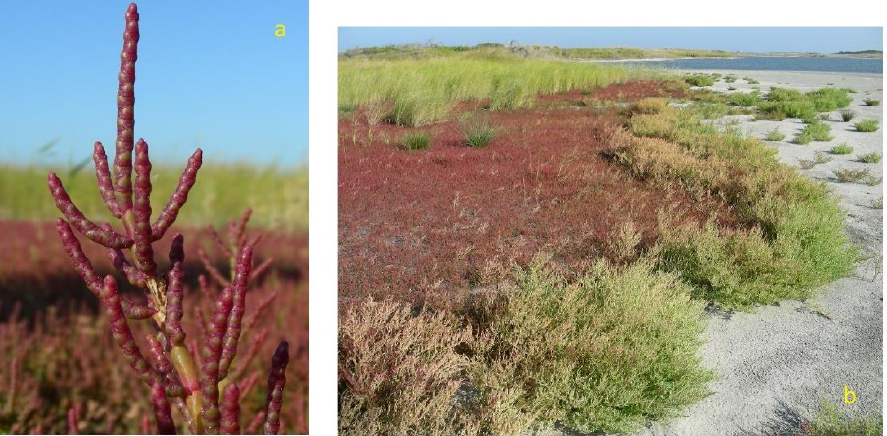
Figure 2. A specimen of Salicornia patula ( a ); S. patula community (( b ); the reddish glasswort carpet) at the edge of a coastal lagoon in Salento.